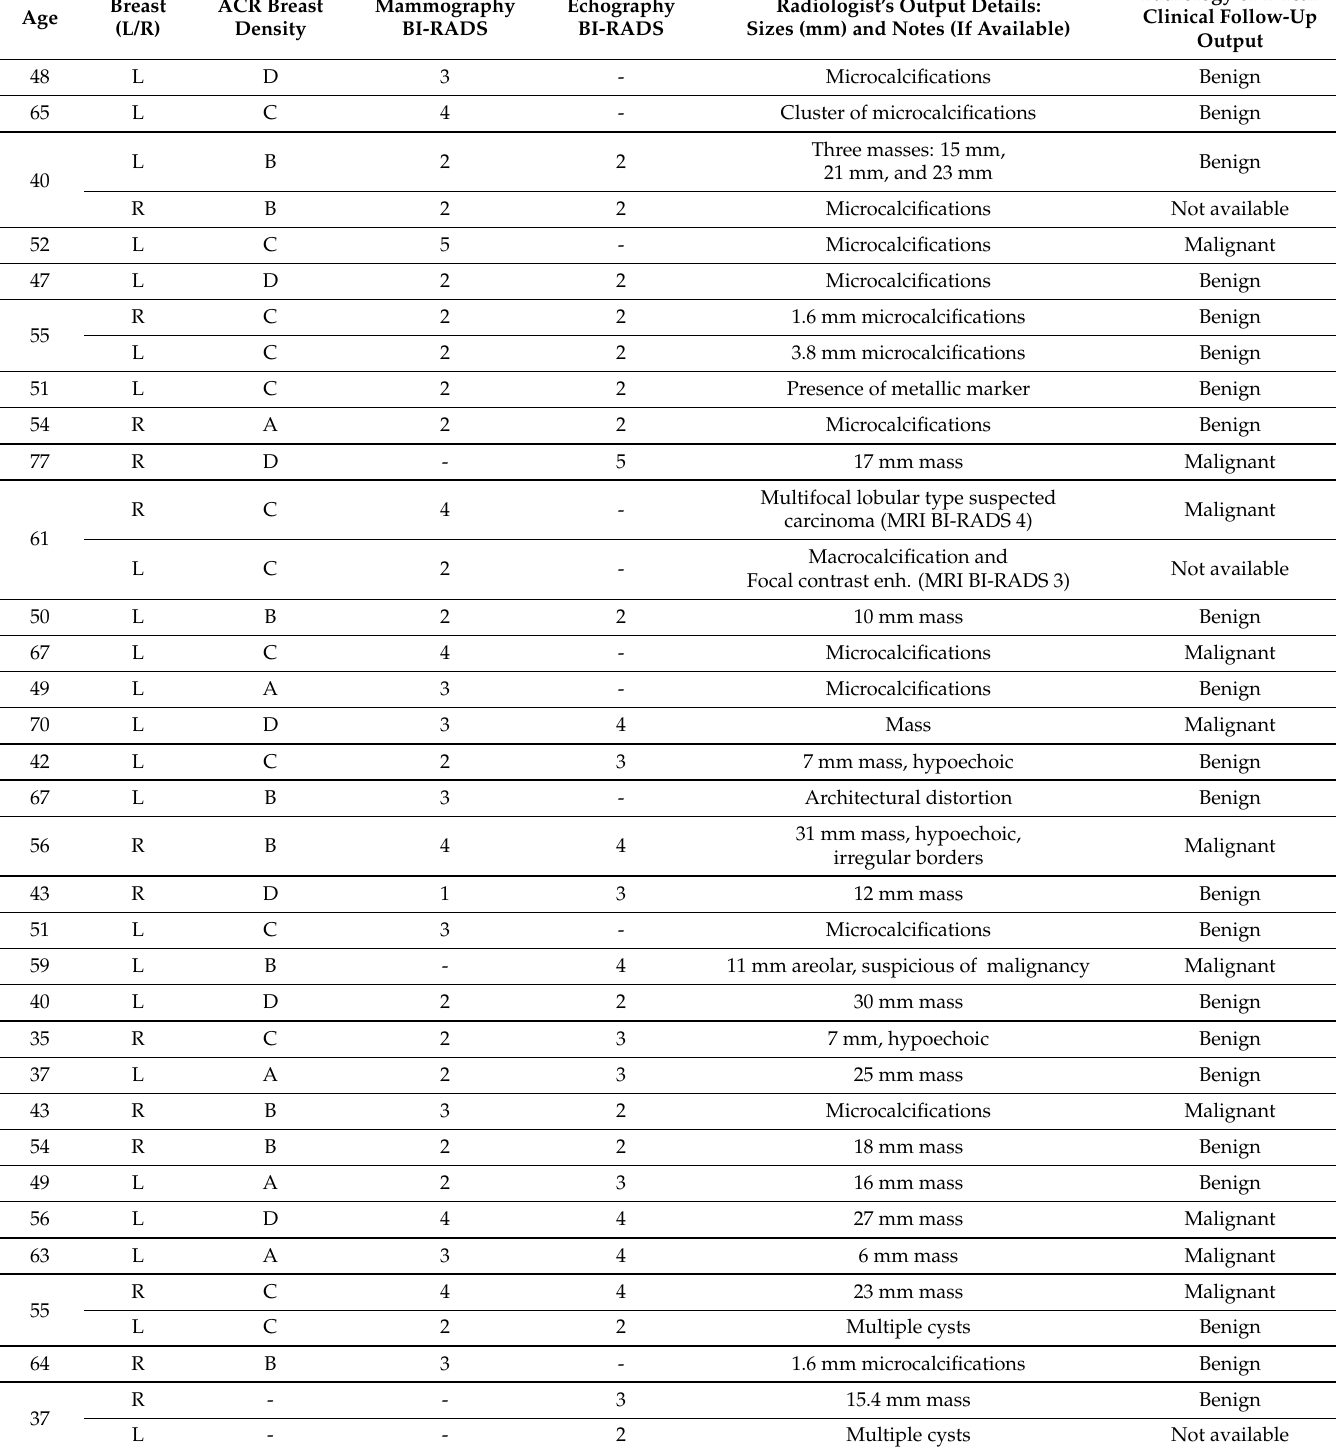
Table 1. Subject lists, details, and related radiologist’s